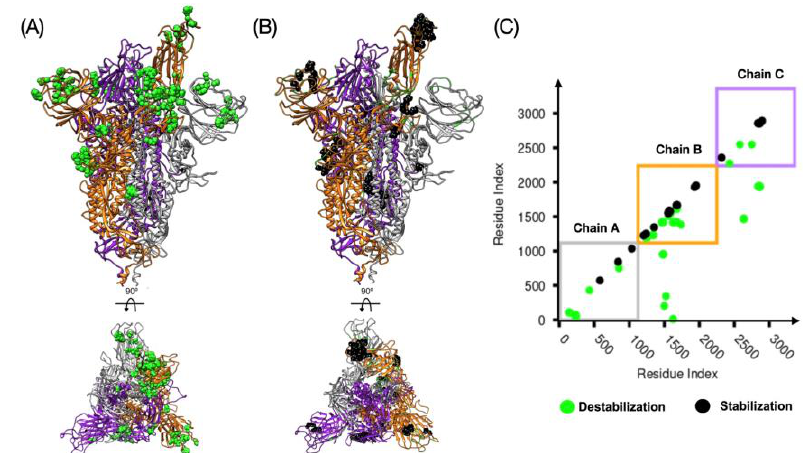
Figure 2. The differential contact map (dCM) analysis (f > 0.9) of the spike protein with 1up2down RBD. The secondary structure of the chain A–C are depicted in gray, yellow, and purple, respectively. Panel ( A ) shows the structure of the homotrimer and in green the amino acid residues that destabilize the spike protein in this conformation. The bottom of panel ( A ) shows the same structure rotated by 90° as indicated, showing that most of the destabilizing residues are positioned between the RBD (in